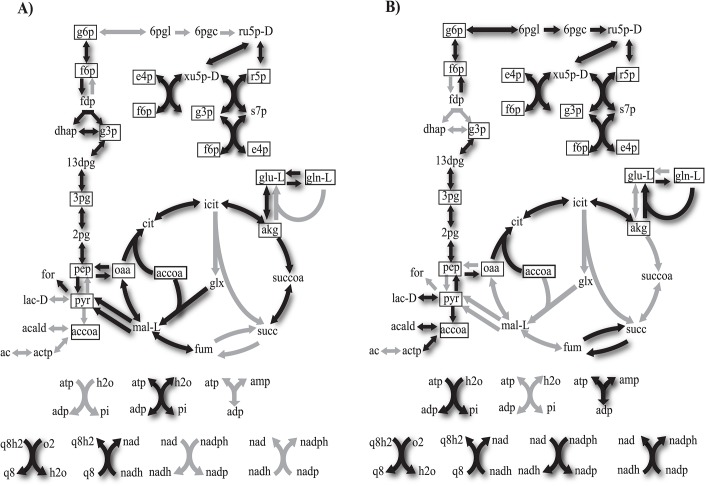
Example of two maximally different metabolisms.Each arrow in each panel corresponds to one of the 51 internal reactions we consider. Black arrows and gray arrows correspond to reactions that are present or absent, respectively, in the metabolism shown. Metabolites are indicated by their acronyms (see S9 Table). Boxed metabolites correspond to 13 essential biomass precursors. Note that 4 metabolites (accoa, g3p, f6p and e4p) are shown more than once for visual clarity. a) A metabolism with 33 reactions that is viable on fructose and that differs from another metabolism of size 33 viable on fructose shown in b) by 16 reactions. The two metabolisms share 17 reactions.